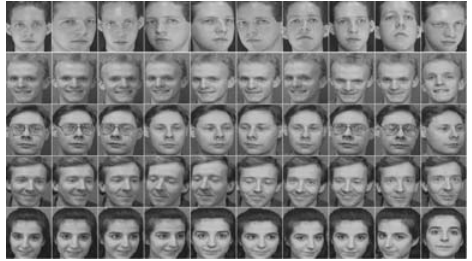
Fig. 6. Sample face images taken from the AT & T face Database.